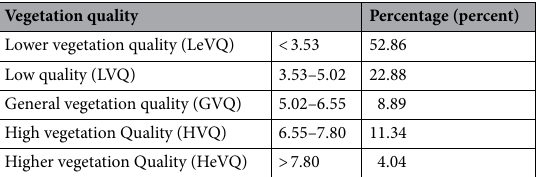
Table 7. The vegetation quality and its proportion on the QTP (percent).